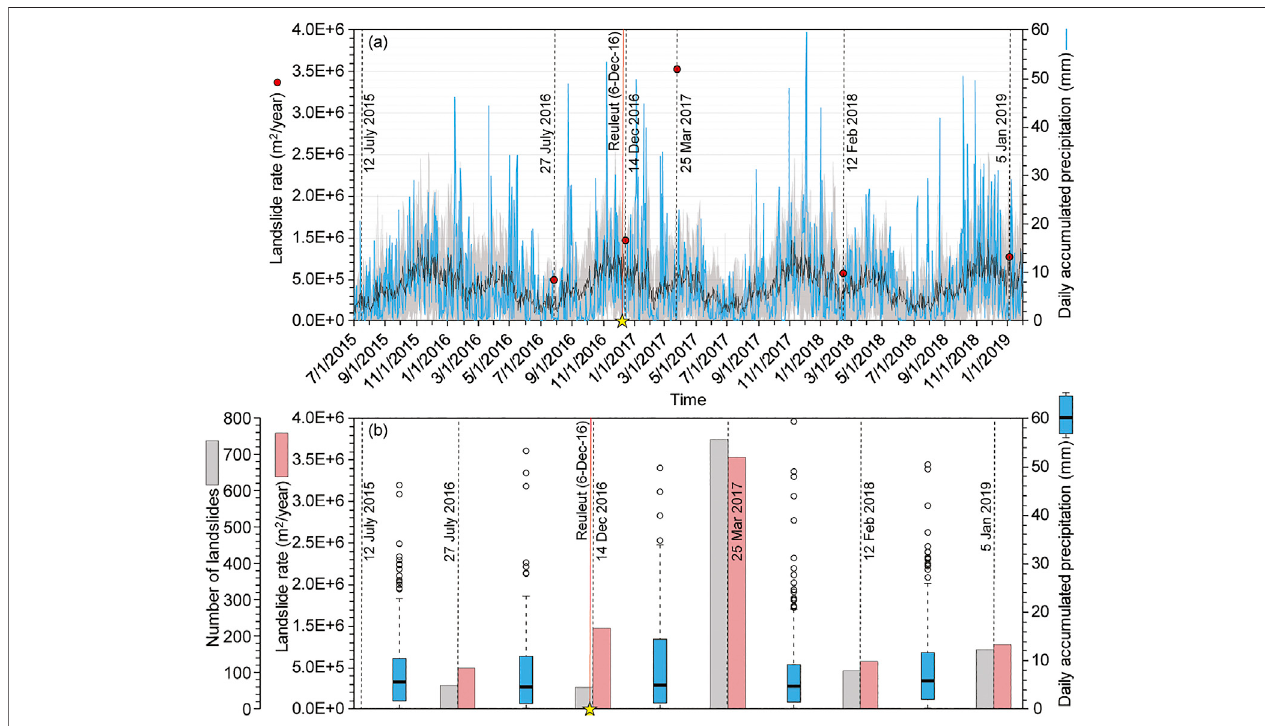
FIGURE 5 | Landslide rates, number of landslides and daily precipitation regarding the examined time windows for the 2016 Reuleuet earthquakes. Yellow stars showthedateoftheearthquake. Verticaldashed blacklinesindicatethedatesofthesatelliteimageryusedformapping.In PanelA ,themeanandstandarddeviationof daily accumulated precipitation of the respective time windows are calculated from a 20-years time series are shown by black and gray lines, respectively. In Panel B , boxplots show minimum, median and maximum precipitation amounts as well as fi rst, third quartiles and outliers.